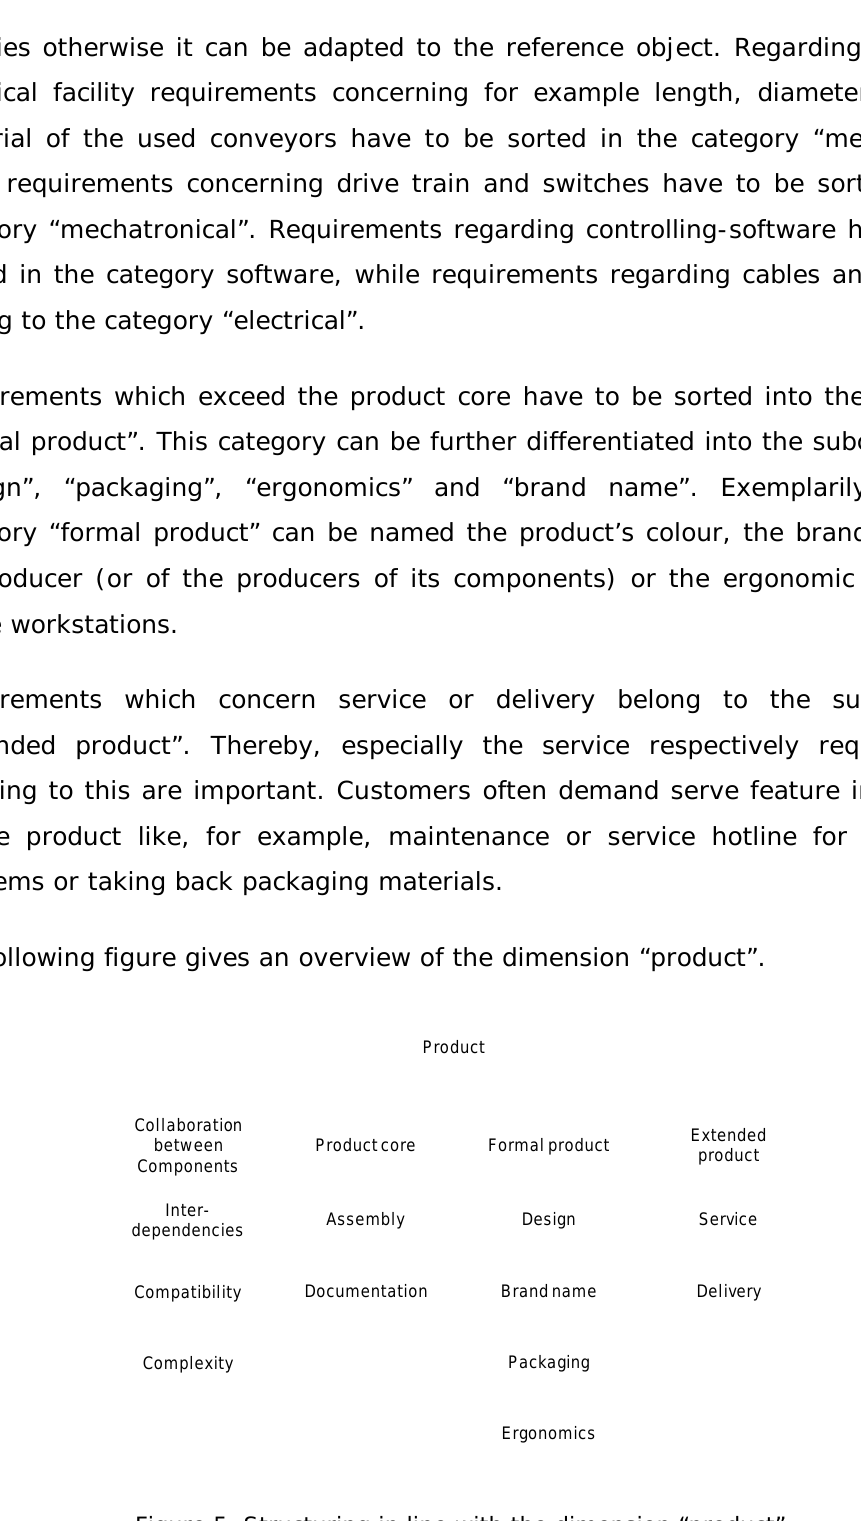
Figure 5. Structuring in line with the dimension